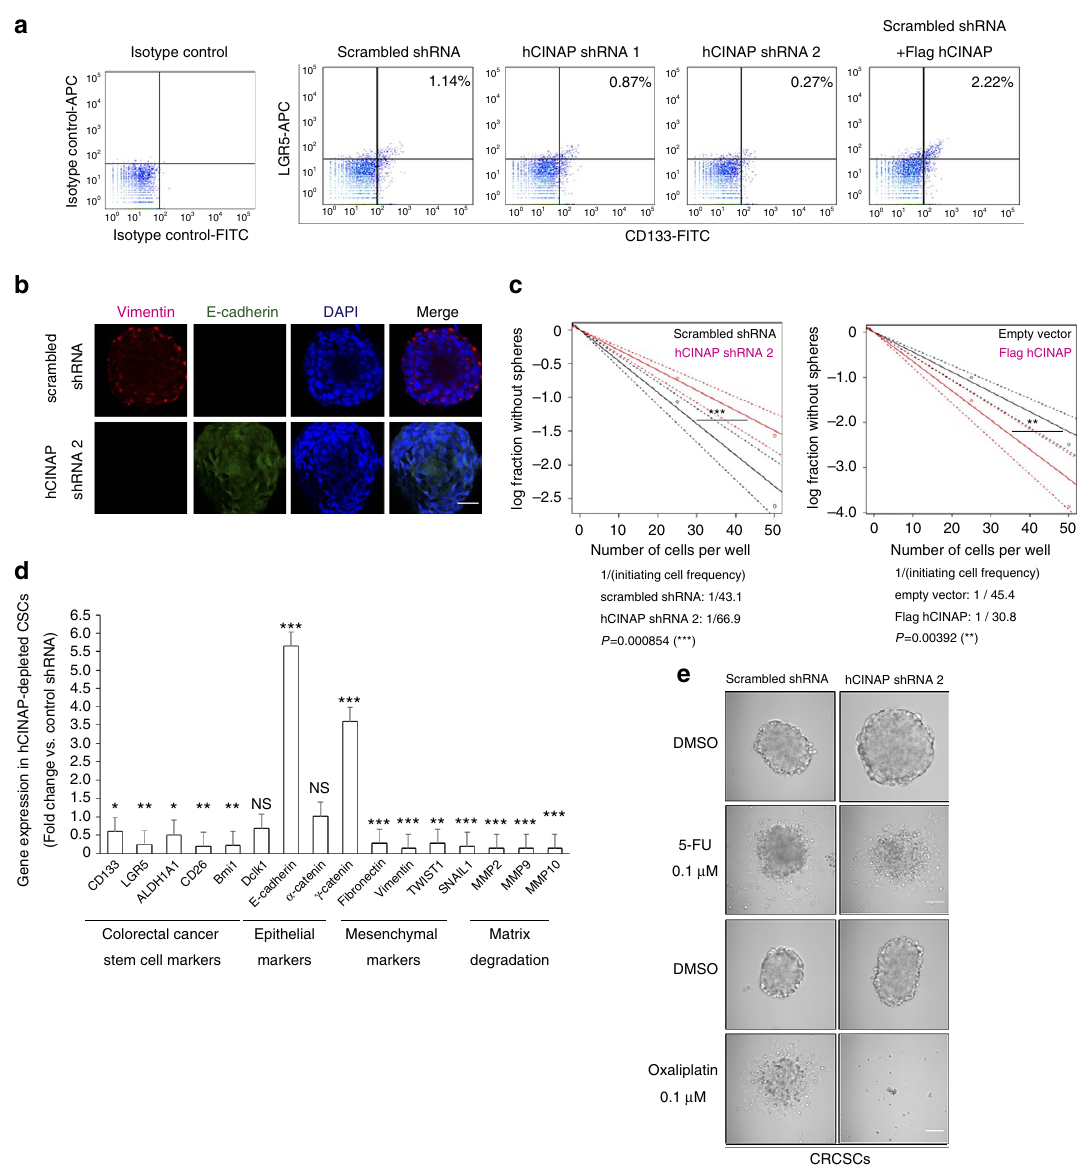
Figure 2 | hCINAP determines CRCSC phenotypes in CRC cells. ( a ) FACS plots of CD133 and LGR5 staining in patient-derived colorectal cancer stem cells (CRCSCs) expressing the indicated shRNAs and plasmids. See also molecularly characterized CRCSCs derived from patient in Supplementary Fig. 5a. ( b ) Immunofluorescence analysis of the effect of hCINAP knockdown by shRNA on the mesenchymal–epithelial transition in CRCSC spheres. Mesenchymal marker vimentin was labelled in red and epithelial marker E-cadherin was labelled in green. The nucleus was counterstained with DAPI (blue). Scale bar, 100 m m. ( c ) Limiting dilution tumorsphere formation assay in CRCSCs with the indicated shRNAs and plasmids. CRCSC frequency was calculated using extreme limiting dilution analysis. ** P o 0.01, *** P o 0.001. ( d ) Representative mRNA levels were analysed by qRT–PCR in CRCSCs as indicated. Gene expression in hCINAP-depleted cells was normalized to that of the shRNA control group. The experiments were performed three times and data are determined by Student’s t -test and presented as mean ± s.e.m. (* P o 0.05, ** P o 0.01, *** P o 0.001, NS, not significant). ( e ) CRCSC spheres were treated with 0.1 m M 5-fluorouracil or 0.1 m M oxaliplatin for 24h and photographed using a bright field microscope in e . Scale bar, 50 m m. Also see that the viable cell inhibition ratio was determined using MTT colorimetry in Supplementary Fig.